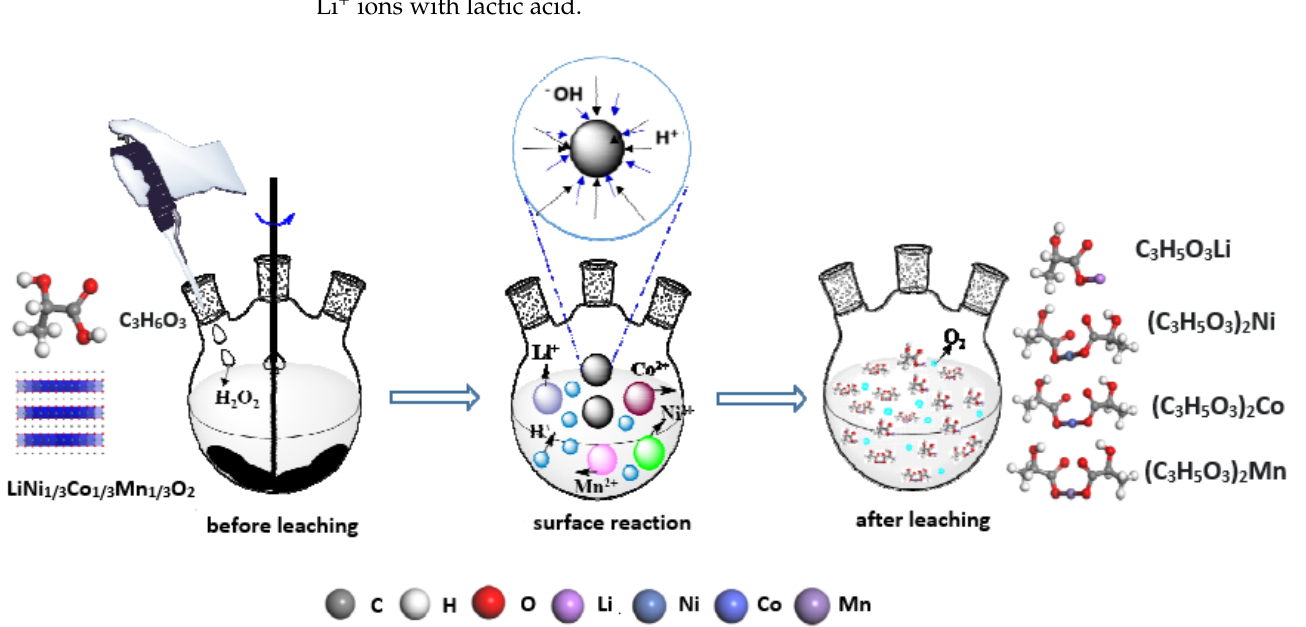
Figure 5. Schematic representation of the possible mechanism and products in the lactic acid leaching process of NCM cathode materials regenerating from discarded LIBs. Reprinted with permission from Ref. [57], Copyright 2017, American Chemical Society.